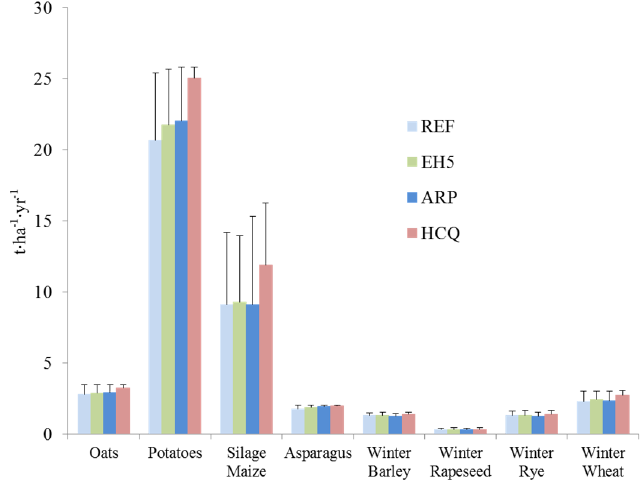
Figure 11. Average additional crop yields by irrigation for multiple climate projections in the period 2018–2052 (bar: median, whiskers: 10th percentile).